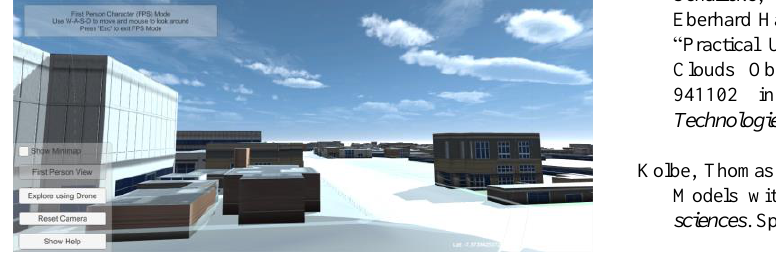
Figure 8. Bird-eye view of the generated visualization Here, users (e.g. future investors) can walk and inspect buildings and underlying parcel boundaries and their corresponding attributes interactively (Figure 8). Land right types and values, as well as building permits, can be explored by users in a walkable 3D city neighbourhood either via first- person or drone mode interactions. The result is a 3D interactive visualization of Solo City area in multiple platforms (i.e. Desktop, web and